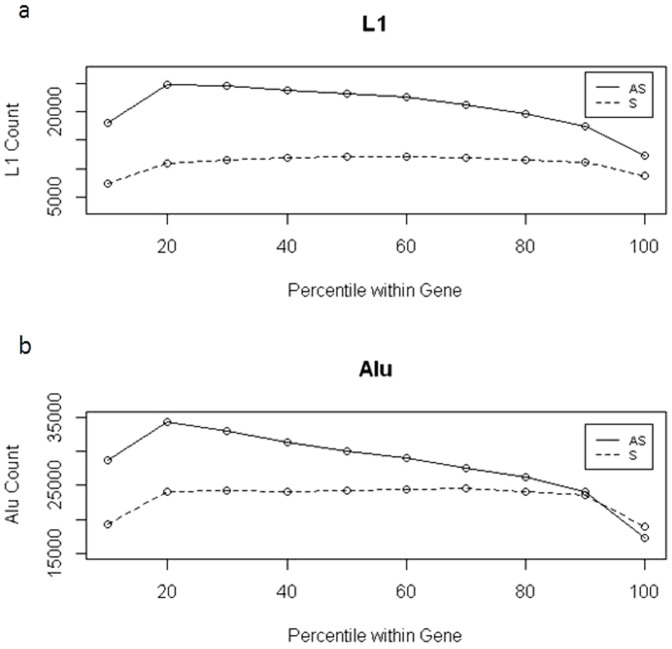
ASO bias decreases linearly across a gene.All L1 (a) and all Alu (b) annotated in UCSC Genome Browser RepeatMasker track (Hg19) were used in this analysis. Raw counts of L1 and Alu were tabulated for each gene decile over all RefSeq genes and subset based on orientation with respect to the colocalized gene. ASO = Antisense oriented (sold lines), SO = Sense Oriented (hashed lines). Slopes of the retrotransposon count over gene decile were calculated excluding the first and last bins, −99.4L1 ASO, 3.3L1 SO, −141.11Alu ASO, −2.7Alu SO.